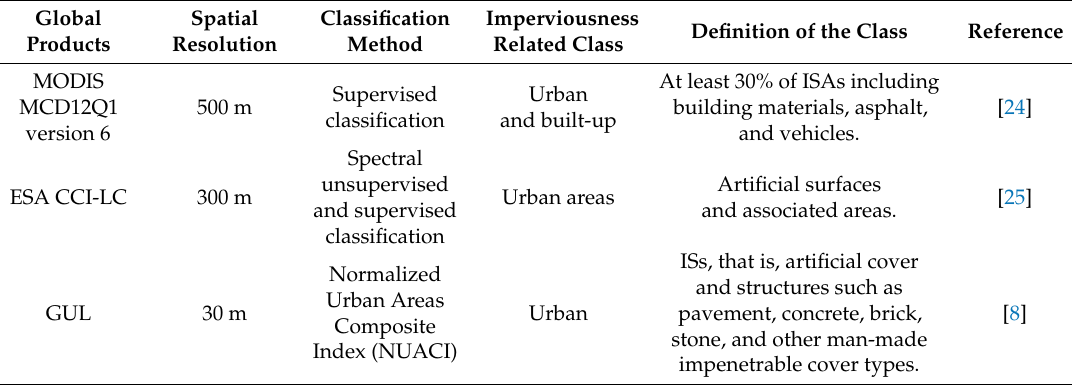
Table 1. Summary of the imperviousness-related classes in the global land-cover products used in this study. ISA, impervious surface area; MODIS MCD12Q1, Moderate Resolution Imaging Spectroradiometer Land Cover Type / Dynamics products; GUL, Global Urban Land; ESA CCI-LC, European Space Agency Climate Change Initiative-Land